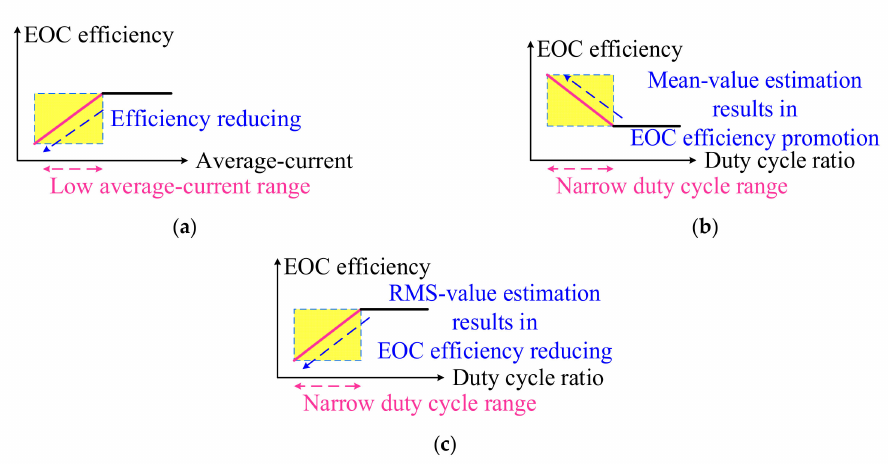
Figure 3. Variances in electro-optic conversion (EOC) e ffi ciencies using average current modulation and PDCM ( a ) Average-current modulation. ( b ) RMS value based on electrical power using PDCM. ( c ) Mean value based on electrical power using